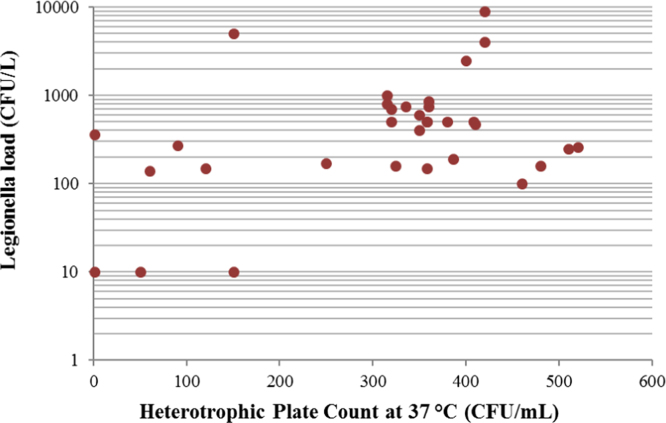
Scatter Plot showing the relationship between Legionella load (CFU/L) and the Heterotrophic Plate Count at 37 °C (CFU/mL). Pearsons’ r = 0.1489; r2 = 0.0222. 3 samples not included in the construction of the plot because the HPC 37 °C was over 800 CFU/mL, so that it couldn’t be determined with accuracy.